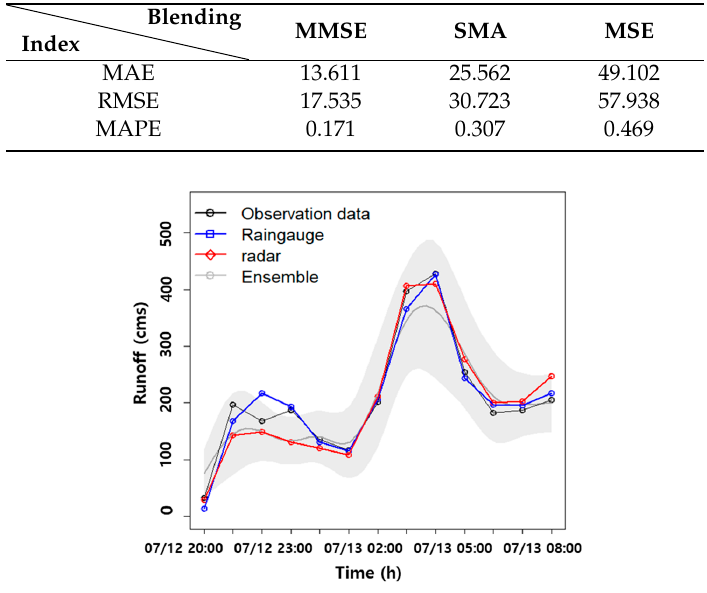
Table 6. Evaluation of blending technique using minimum ensemble data.